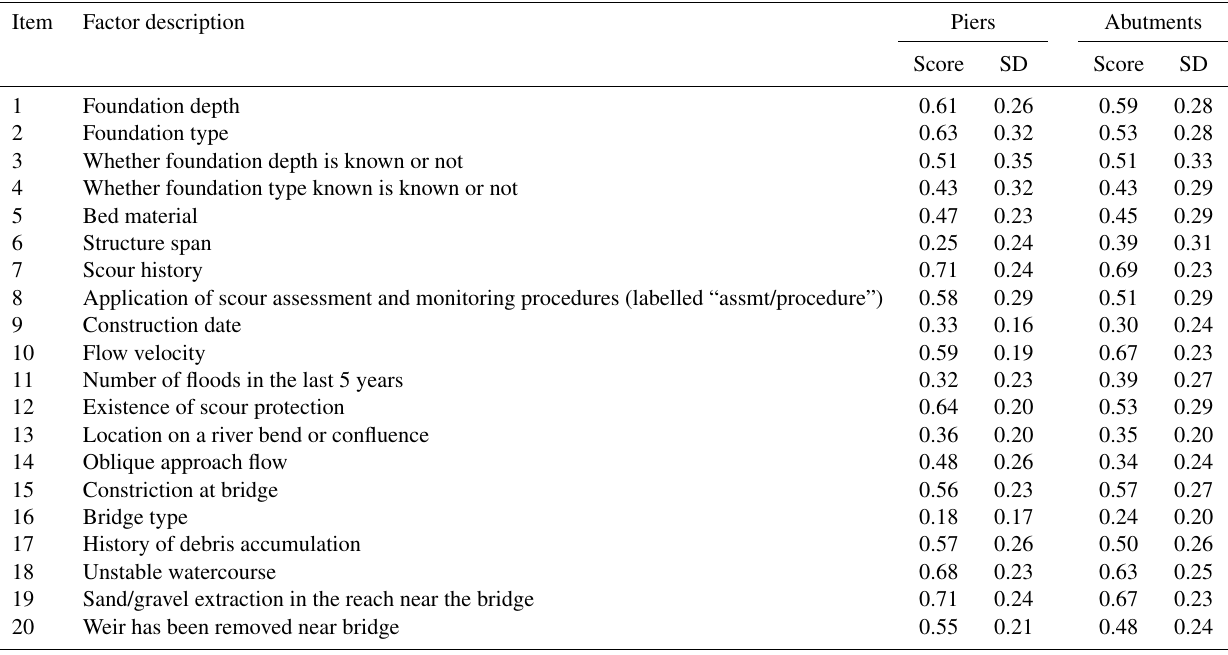
Table 3. Ranking scores for the importance of factors that should be considered when assessing scour risk to bridges (question 1). Higher score indicates greater importance. SD is the score standard deviation derived from probabilistic inversion of experts’ collective responses.